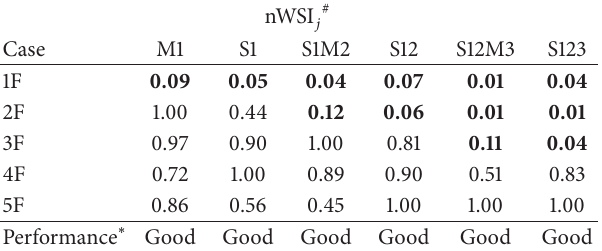
Table 3: Summary of damage assessment w/full observation (exper-